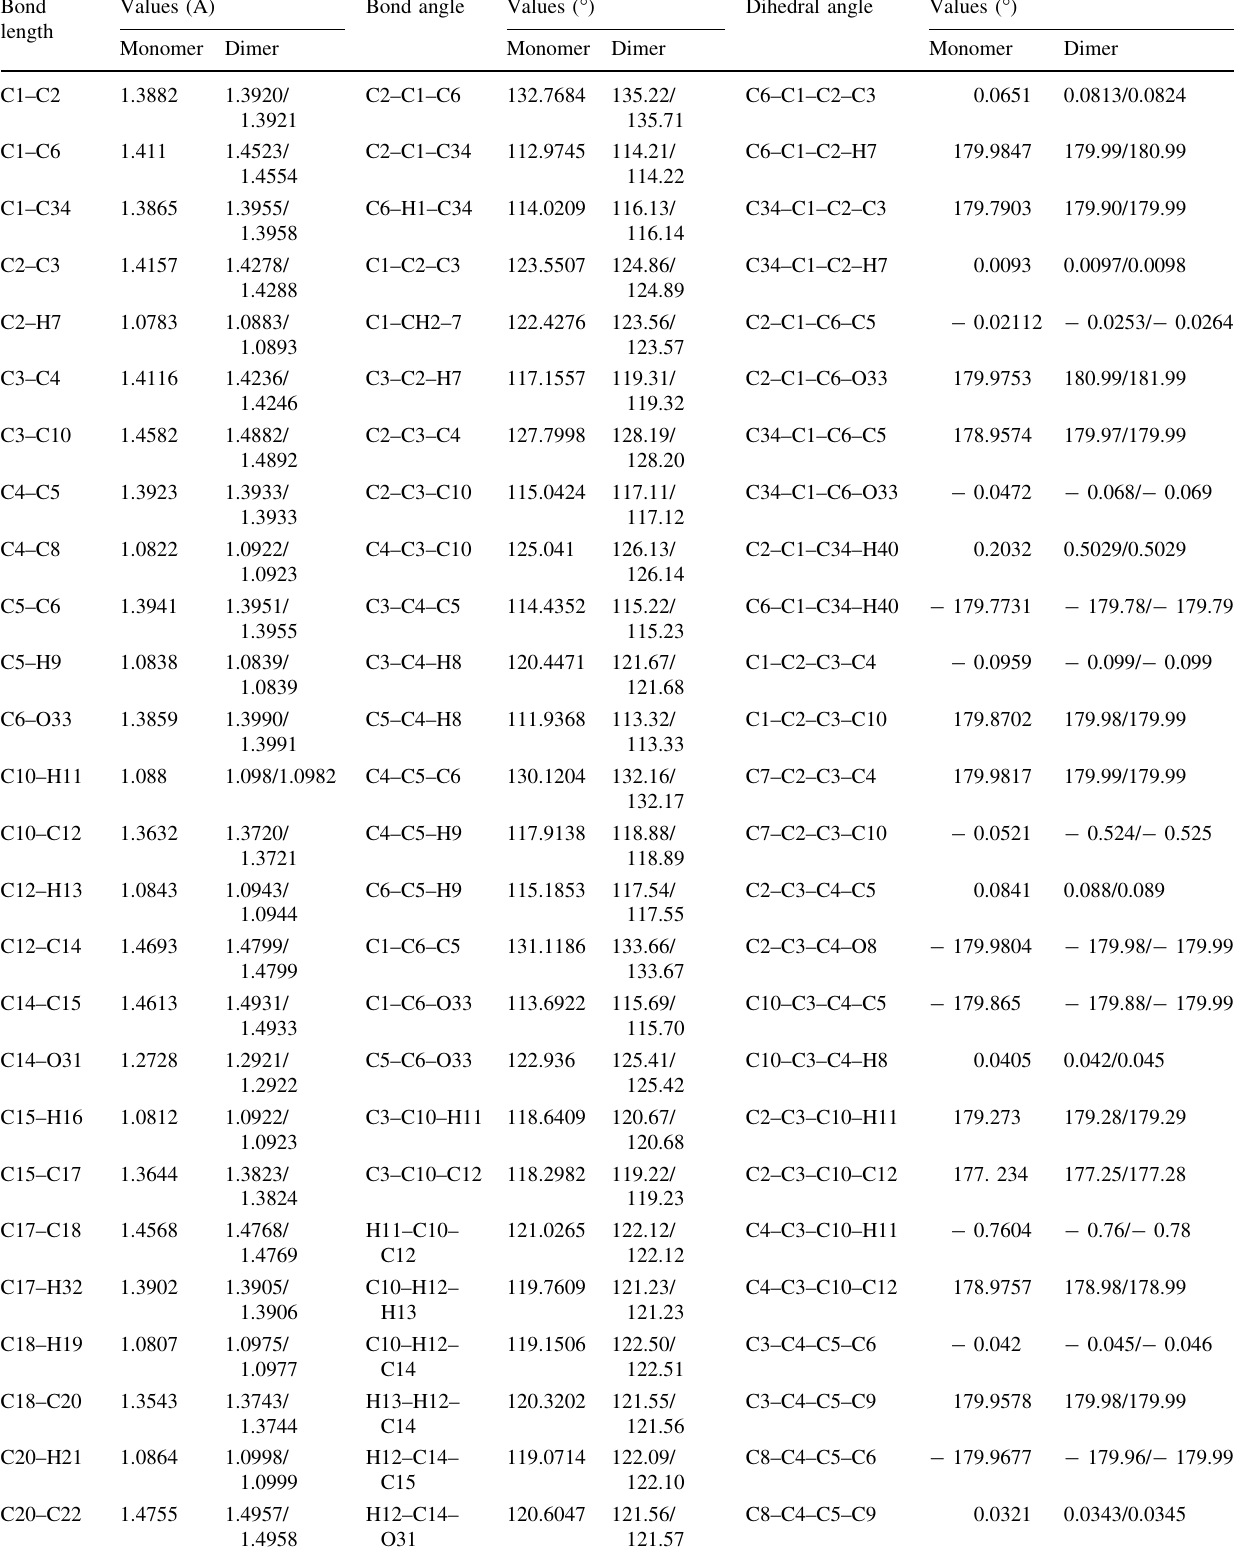
Table 1 Optimized parameters of Curcumin using B3LYP/6-311 ?? G(d,p) method Bond